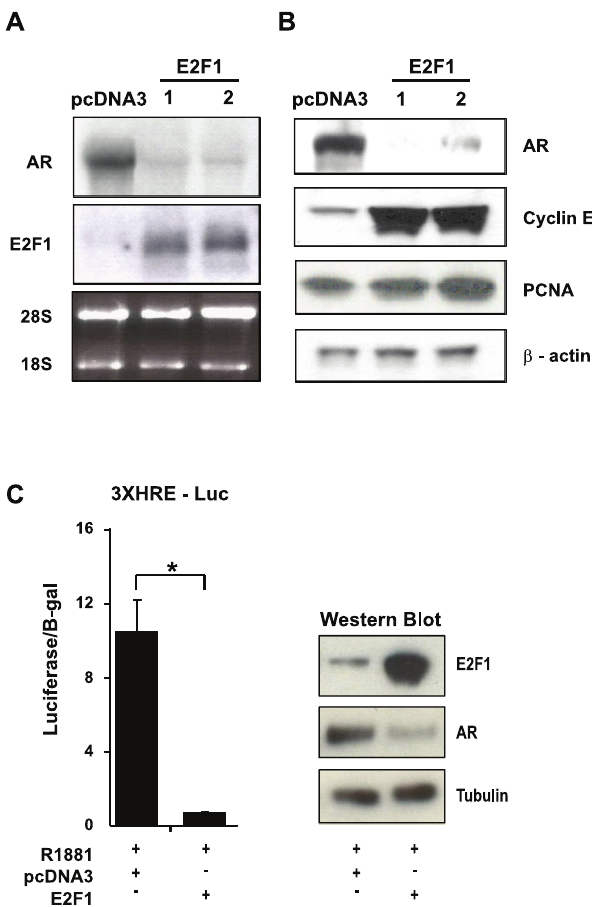
Figure 2. Exogenous E2F1 inhibits both AR expression and responsive promoters. ( A) Northern blot analysis of stably transfect- ed mouse prostate epithelial cells (PrE) with either pCDNA3 (control vector) or E2F1 shown as E2F1-1 and E2F1-2 to detect AR and E2F1 gene transcription. The 28S and 18S ribosomal bands are shown for loading comparison. ( B) Western blot analysis of whole cell lysates harvested from PrE cells stably transfected with pcDNA3 (control) or E2F1 for the detection of AR, Cyclin E, and PCNA. b -actin is shown as a loading control. ( A and B) The northern blot and western is representative of 3 separate experiments. LNCaP cells were co- transfected with 1 m g of ARE-Luc ( C) and 500 ng of either empty pcDNA3 vector or E2F1 in the presence of 10 2 9 M R1881. Results were normalized to b -galactosidase (B-gal) from a co-transfected CMV promoter driven B-gal reporter construct. The histogram represents the mean value of three independent experiments with the indicated standard deviation. The western depicts the expression levels for E2F1 and AR relative to tubulin for the transfection and treatment conditions. * indicates P , 0.05 for the indicated comparison in